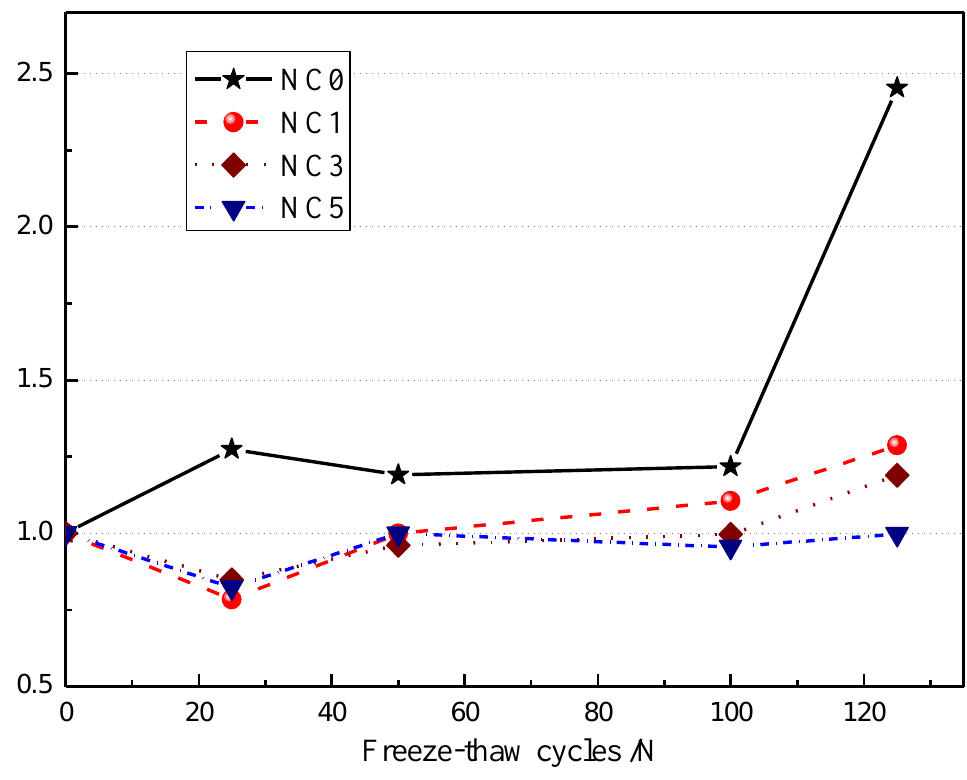
Figure 12. Relationship between the relative peak strain of concrete and freeze – thaw cycles. 3.4.3. Initial Elastic Modulus and Peak Secant Modulus of Concrete The slope of the compressive stress-strain curve (σ – ε ) is its elastic modulus or de- formation modulus, which is called the tangent elastic modulus when it is taken as the tangent slope dσ / dε ; when σ / ε is taken as the secant elastic modulus. When σ = f c , ε = ε c , the tangent elastic modulus is 0, and the peak secant modulus E c is Formula (2): c c c f E = (2) when σ =0, ε =0, the tangent elastic modulus is equal to the tangent elastic modulus, and the initial elastic modulus E 0 is Formula (3): (3) The relationship between the initial elastic modulus, peak secant modulus, and freeze-thaw cycles of concrete under freeze-thaw action is shown in Figure 13. It can be seen from the figure that with the increase in freeze-thaw cycles, the initial elastic mod- ulus and peak secant modulus of concrete show a decreasing trend. The initial elastic modulus and peak secant modulus of NC5 decrease slightly. NC0 and NC1 change sig- nificantly.